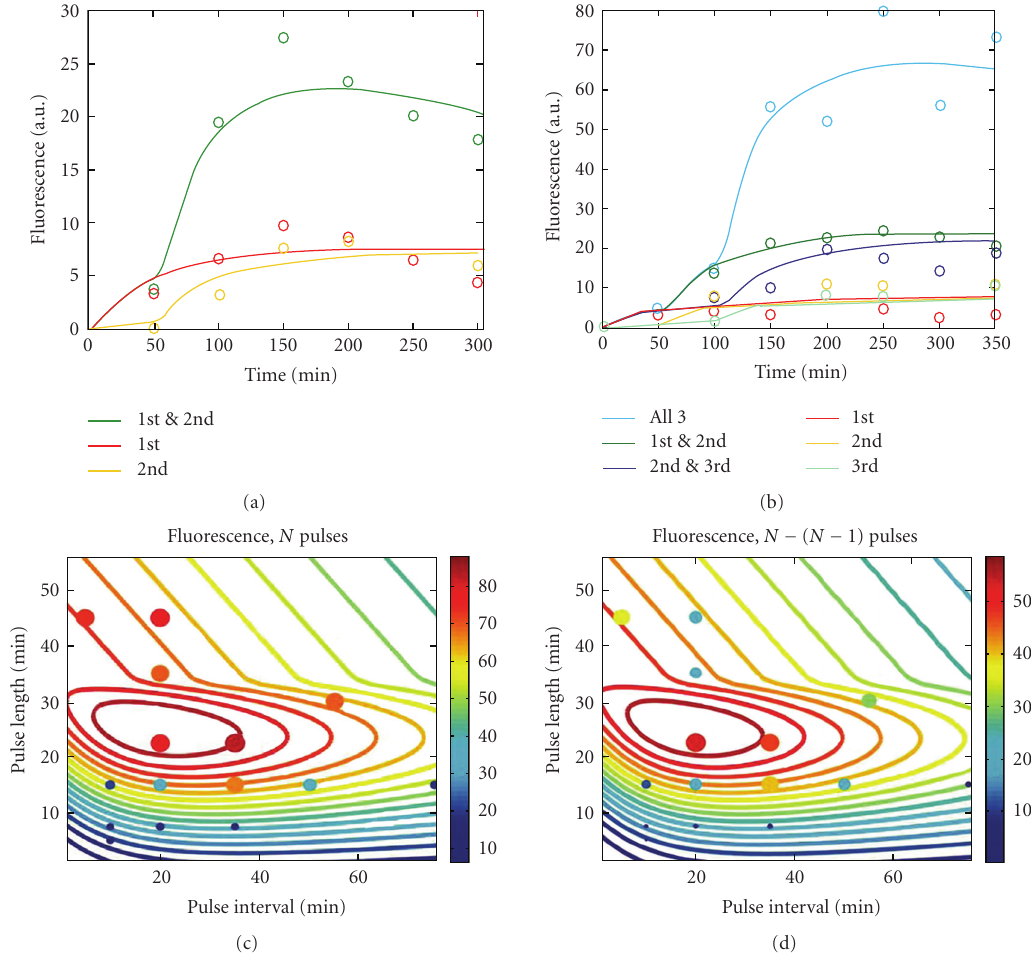
Figure 6: Modeling predictions and analysis of the RTC three-counter in Friedland et al. [7]. (a) A model of (a) the RTC two-counter and (b) the RTC three-counter with fitted parameters was simulated (solid line) and agrees well with experimental data (normalized fluorescence, solid dots). (c) The output of the RTC three-counter ( N pulses) is simulated for a range of pulse lengths and intervals. The predictions (colored contour lines) match experimental results (solid circles), whose levels are indicated by both color and size. (d) Similar to (c), except that values shown here are the di ff erences in the output of the three-counter after three ( N ) pulses and two ( N – 1) pulses (from Friedland et al. [7], with